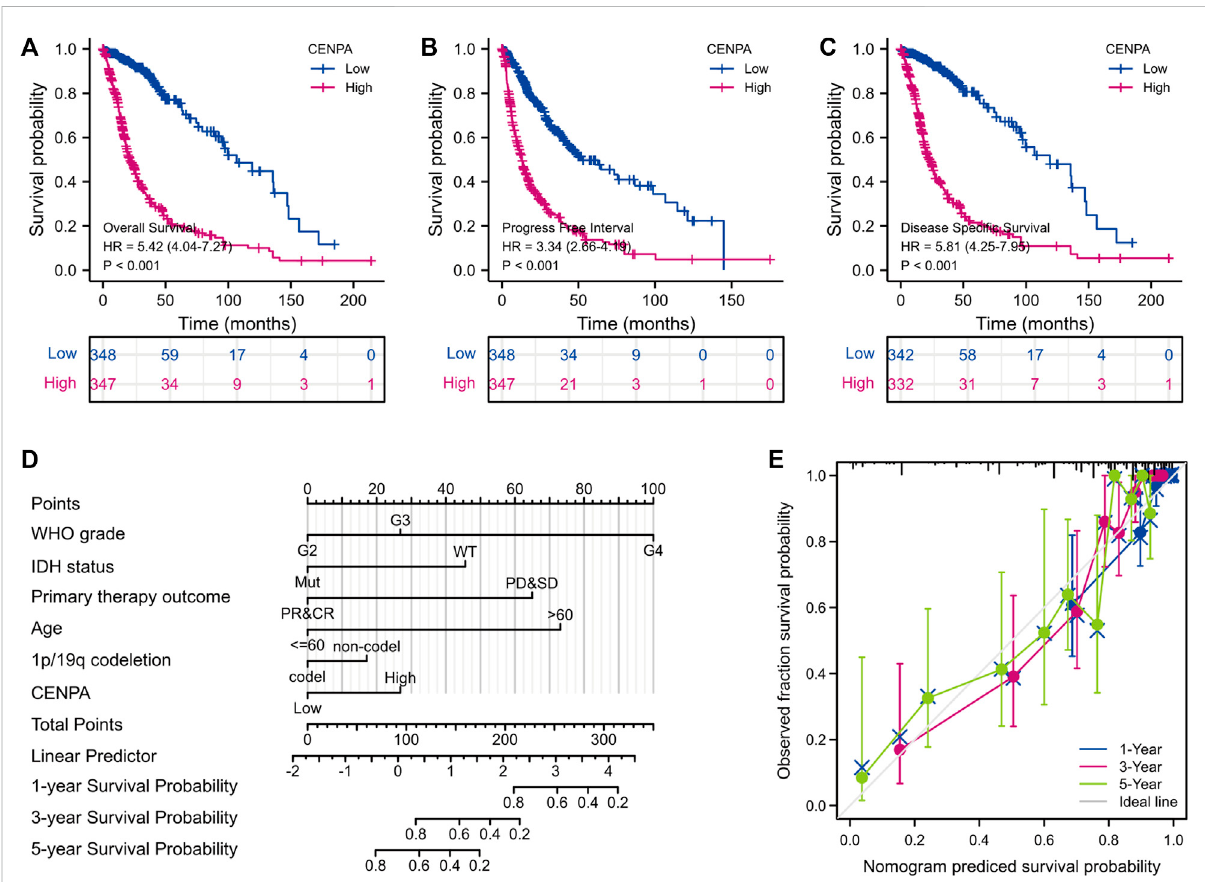
FIGURE 3 Survival analyses and prognostic nomogram. (A – C) Impact of CENP-A on the overall, progression-free, and disease-speci fi c survival rates in glioma according to TCGA. (D,E) Development and veri fi cation of a glioma predictive nomogram based on CENP-A expression levels and independent prognostic